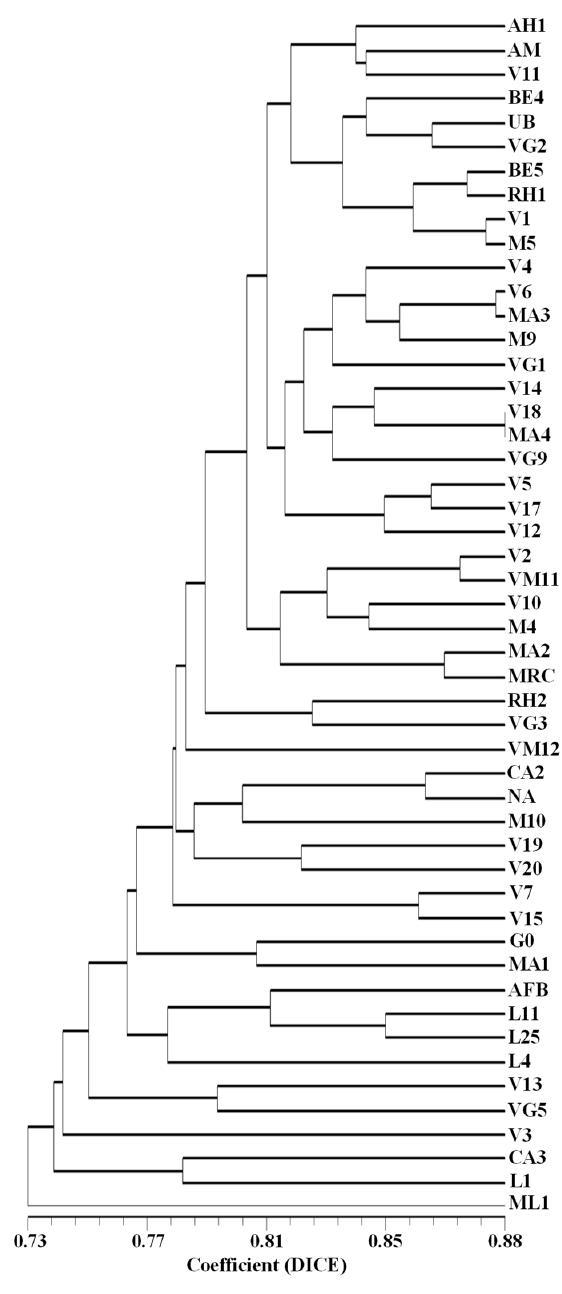
Figure 6. Dendrogram depicting the genetic relationships among the set of 50 strawberry tree (Arbutus unedo L.) germplasm accessions selected for a breeding program, established based on the results of species-specific SSR and SNP-CAPS markers and the randomly amplified RAPD and ISSR markers. Notice the calculated higher genetic similarity values compared to the established uniquely based on the SSR and SNP-CAPS markers (Figure 4).